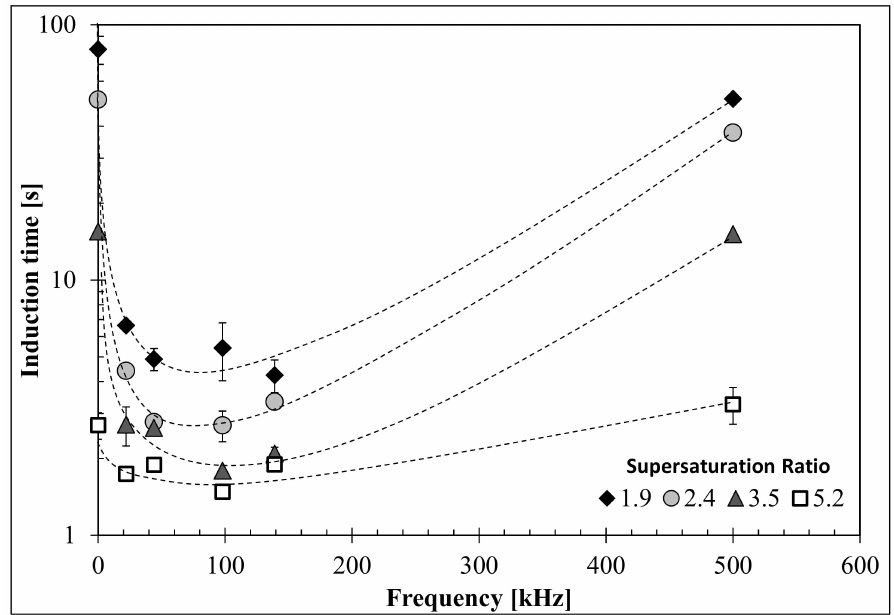
Figure 9. Induction time as a function of sonication frequency for different supersaturation ratios. For all the frequencies the calorimetric power and stirring speed were fixed at a calorimetric power of 1.87 W and 100 rpm, respectively. The dotted lines have been drawn to guide the